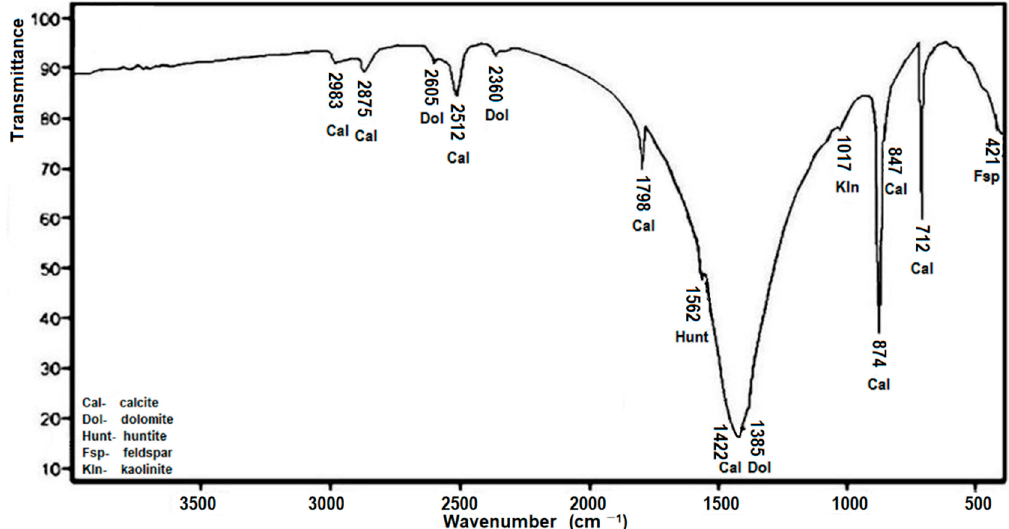
Figure 11. Infra-red absorption spectrum of sample SO1, limestone of the Dziewkowice Unit taken in the Strzelce Opolskie Quarry [21,22,24].